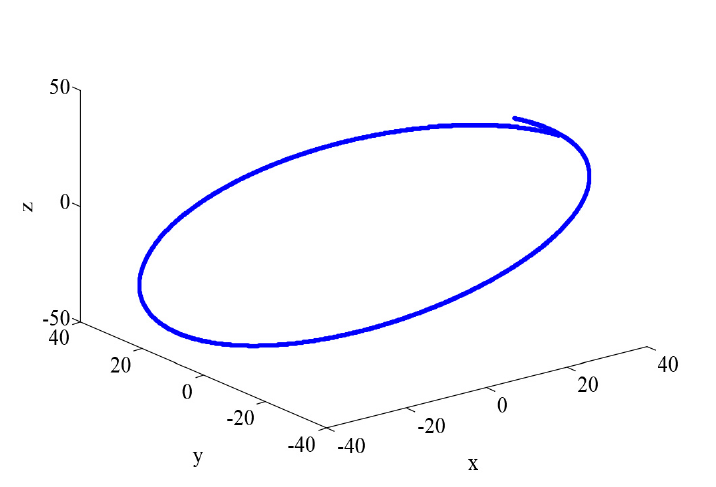
Figure 3. Relative motion of the deputy spacecraft in the Hill frame.